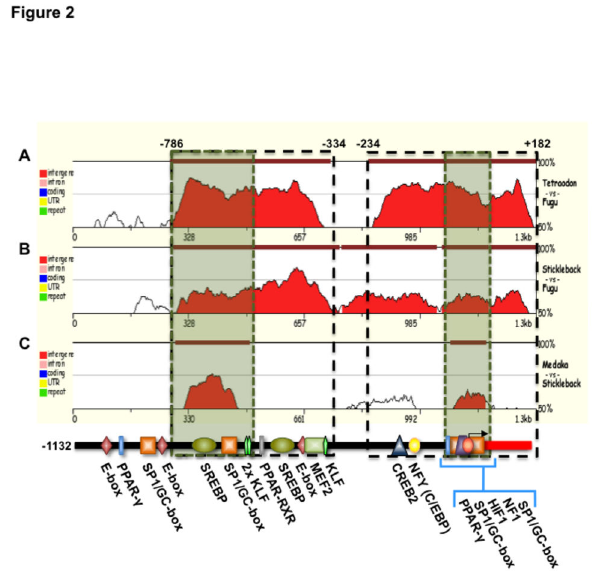
Figure 2. Conservation profile of the 5´ region of the known fish GLUT4. genes . Sequence elements of significant length (≥ 100 nucleotides) that present a sequence homology higher than 60% are highlighted in red and depicted with the dark-red rectangles on the top of the graph. Each graph represents the sequence comparison between the Fugu and Tetraodon (A), Fugu and Stickleback (B) and Stickleback and Medaka (C) GLUT4 promoters. The horizontal axis represents the position of the nucleotides within the 1314 bp sequence compared, starting at the 5’ end of the sequence. The vertical axis represents the percent of identity between the aligned genomes. In the bottom we show a schematic representation of the -1132 Fugu GLUT4 gene promoter that highlights the most relevant predicted binding sites. The open boxes delineating the regions comprised between -786/-334 and -234/+182 nucleotides represent conserved areas in teleost GLUT4 gene